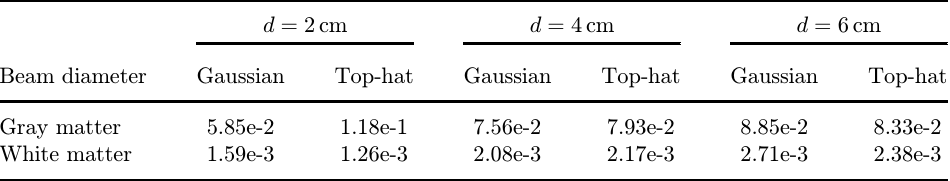
Table 5. Accumulated °uence of light-penetrated voxels within brain tissue. Std < 0 : 01 %Mean